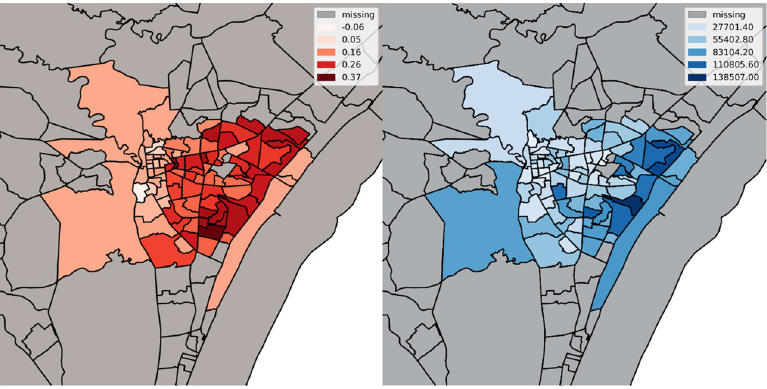
Fig 2. Shift in Family Colocation across CBGs (Left) of Different Median Household Income (Right) at Wilmington. This figure is generated using open source Python and its matplotlib library, in addition to the Open Census Data dataset from SafeGraph, which is available under the CC0 license.